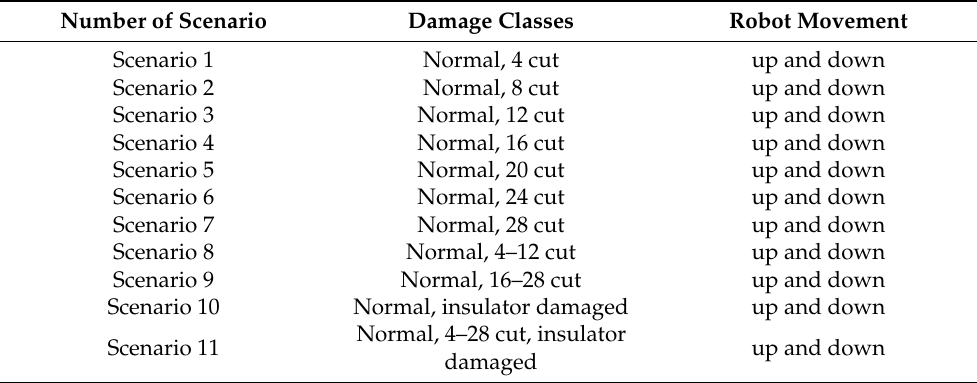
Table 4. Scenarios for